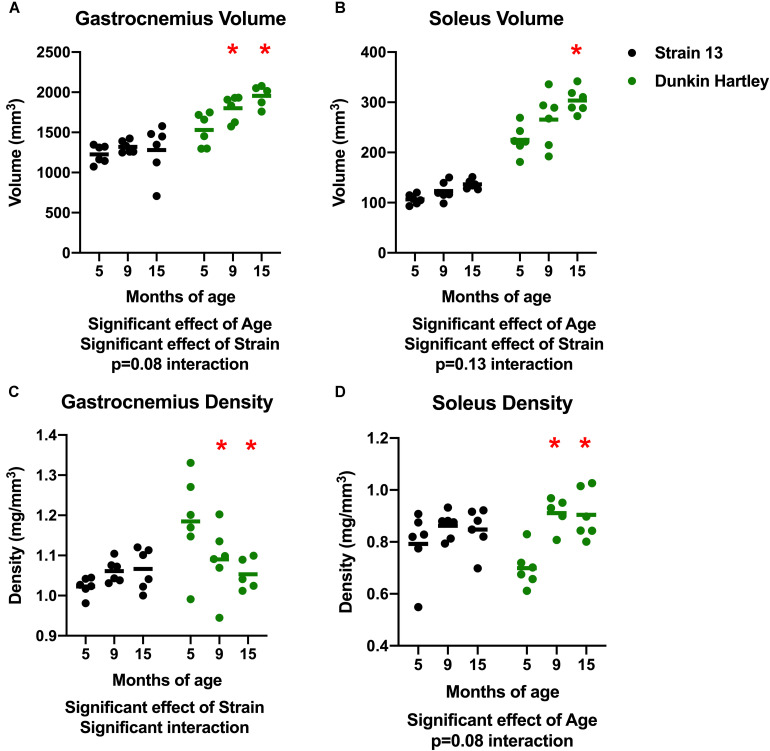
Differences in muscle volume and density. There was a significant, positive effect of age on gastrocnemius (A) and soleus (B) muscle volume, though there was a non-significant interaction in the gastrocnemius, suggesting the increase in volume primarily occurred in Dunkin Hartley guinea pigs. Gastrocnemius density was significantly lower in 9 and 15 mo Dunkin-Hartley guinea pigs compared to 5 mo counterparts, whereas there was no differences observed in Strain 13 guinea pigs (C). In the soleus, muscle density was significantly greater in 9 and 15 mo Dunkin-Hartley guinea pigs compared to 5 mo (D). *denotes p < 0.05 compared to 5 mo.